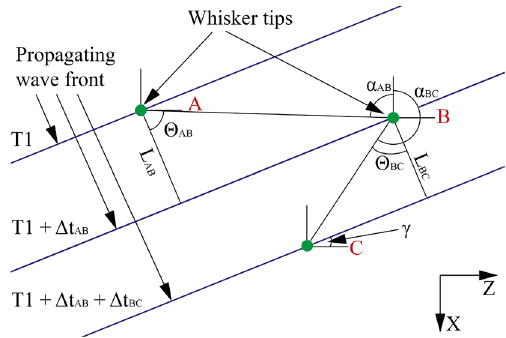
Figure 5. An example triplet of whisker tip points, showing how TDOA multilateration calculations are adapted for this purpose. The blue lines represent the position of the bow wave front, as it passes by and disturbs the